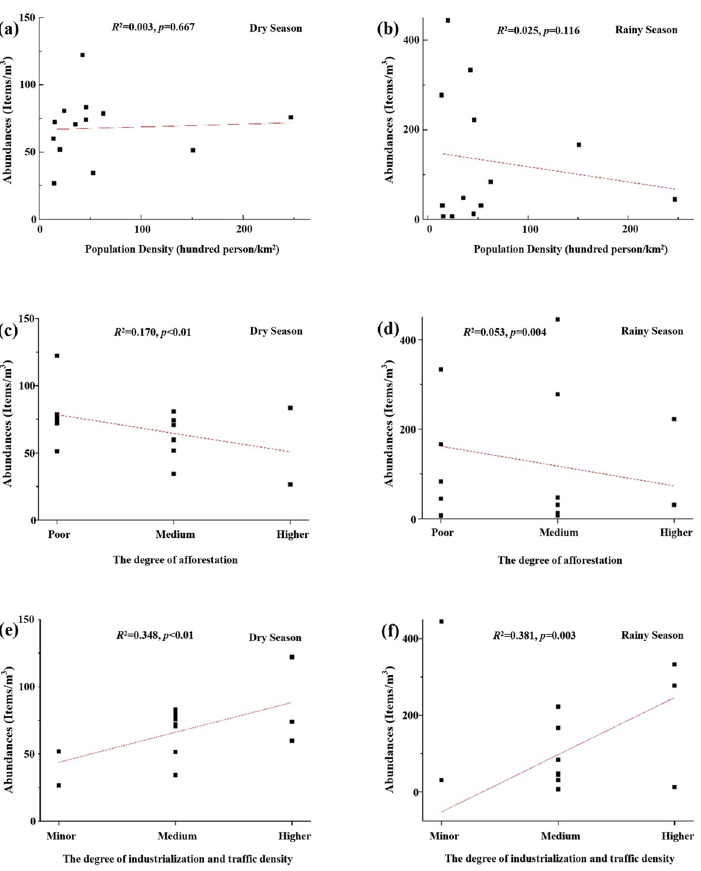
Figure 9. Pearson correlation analysis between microplastic abundances and ( a , b ) population den- sity; ( c , d ) the degree of afforestation; ( e , f ) the degree of industrialization and traffic